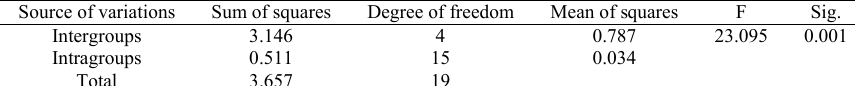
Table13: Tukey’s test